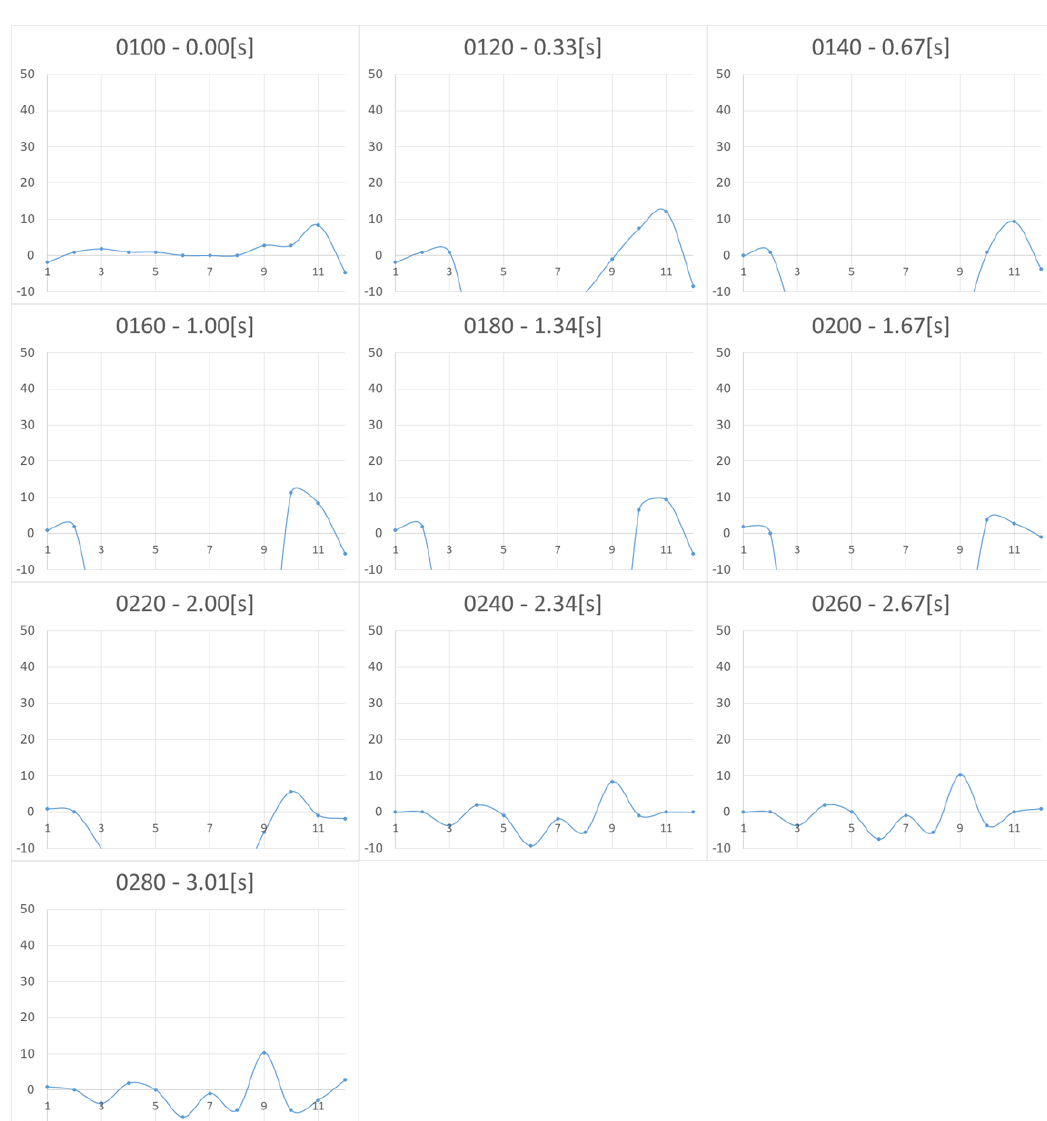
Figure 6. Change in pressure distribution for baby powder (2D view, longitudinal section of the center). The vertical axis represents the force (in milli Newton). The horizontal axis shows the location of the sensing point. The four-digit numbers in each graph show the frame numbers at the time of measurement. Measurements were taken in 0.0165 s/frame (60 fps).